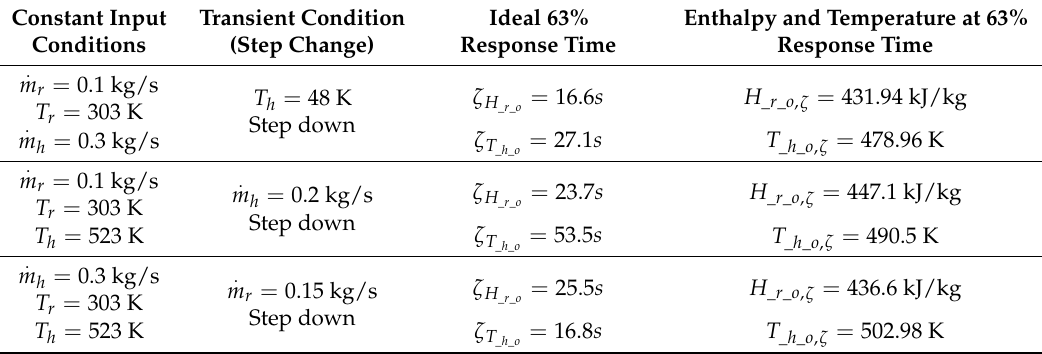
Table 2. Ideal response time of finite volume (FV) evaporator model outputs.